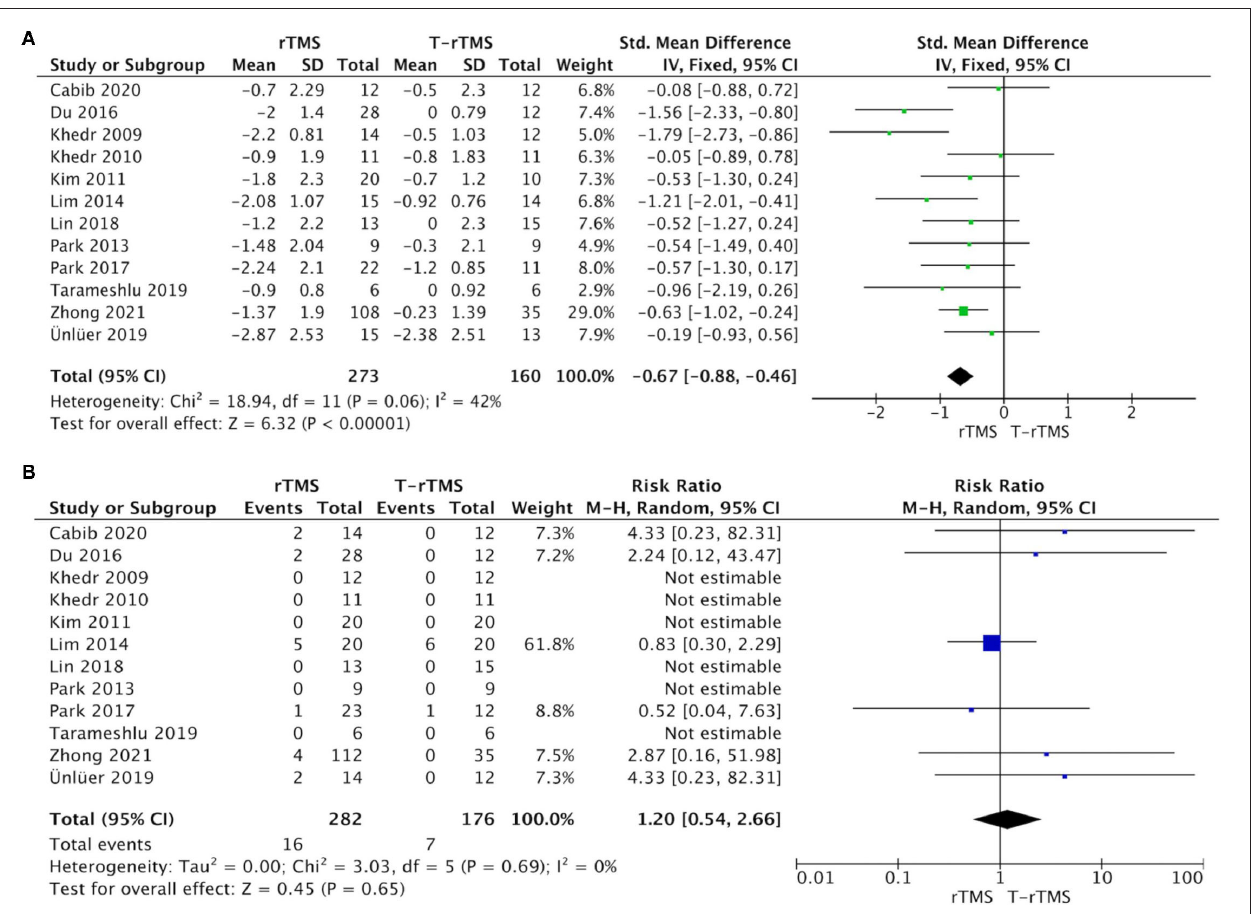
FIGURE 2 | Primary efficacy outcomes and acceptability outcomes. (A) Forest plot of the standardized mean difference (SMD) for change scores in dysphagia severity rating scales. (B) Forest plot of risk ratios (with 95% confidence intervals) of dropout for any reason.